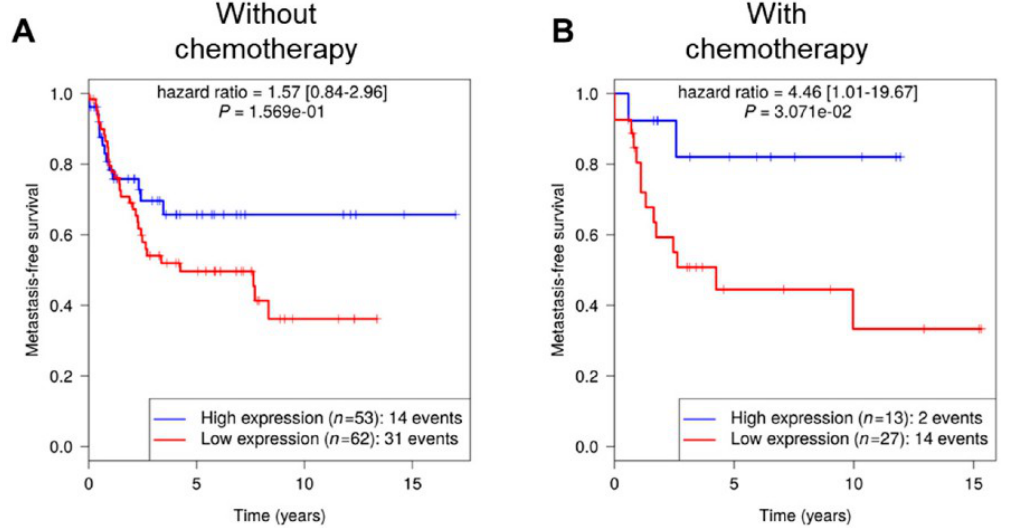
Figure 2. RCBTB1 is significantly associated with metastasis-free survival for patients who received chemotherapy. Metastasis-free survival (MFS) for sarcoma patients is split according to the RCBTB1 expression level determined by microarrays. Cohorts correspond to patients that did not ( A ) or did ( B ) receive chemotherapy.